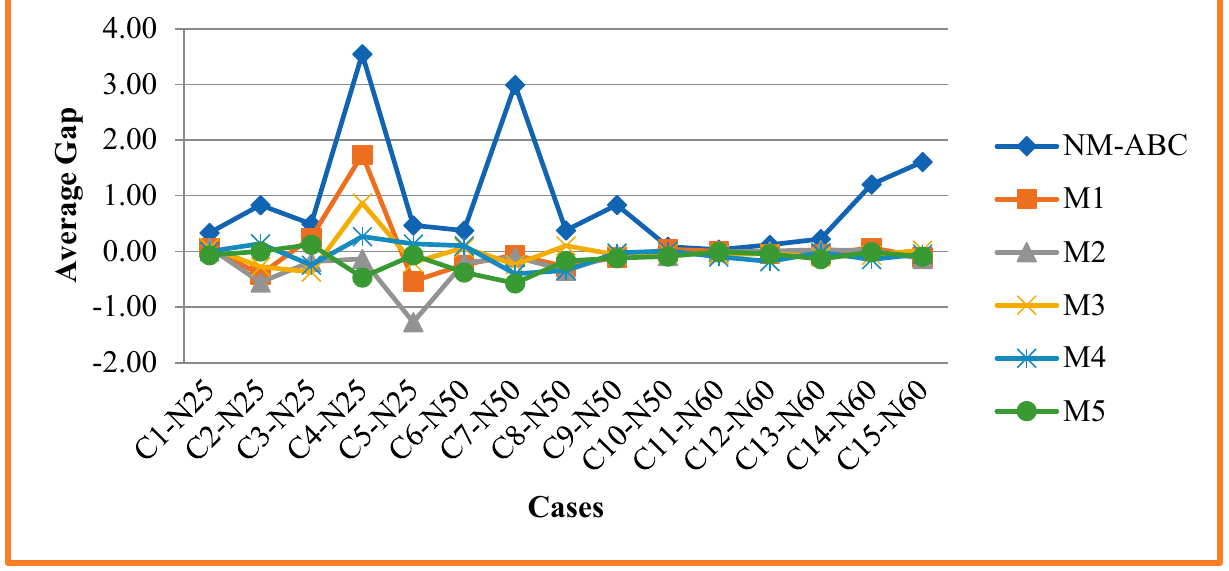
Figure 7. Analysis and Comparison of Average Gap.